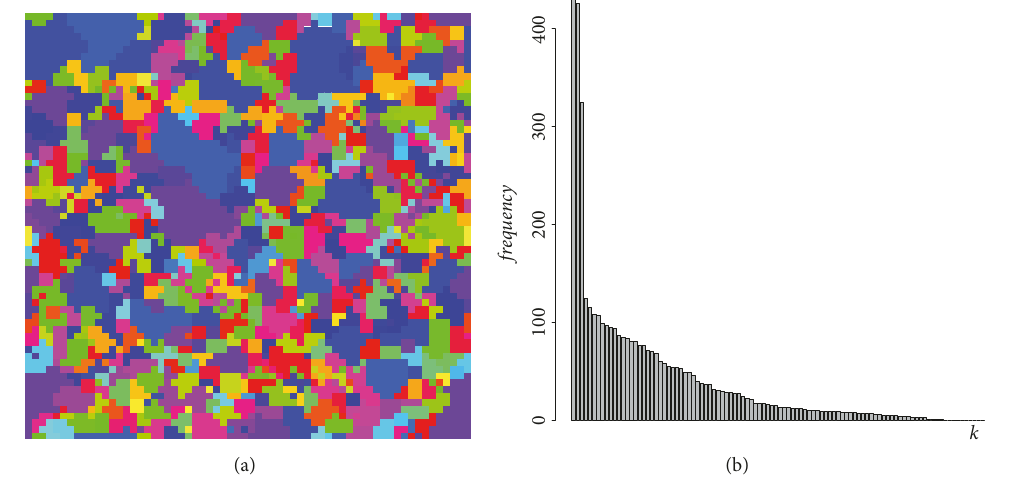
Figure 5: Example of a fixed point solution for 𝑠 = 10 , 𝑝 𝑎 = 0.75 , and 𝑝 𝑏 = 0.25 . (a) The spatial patterns of selected schools (the colormap labels the states {1,2,. .. 100} ). (b) The distribution of the number of students per school.